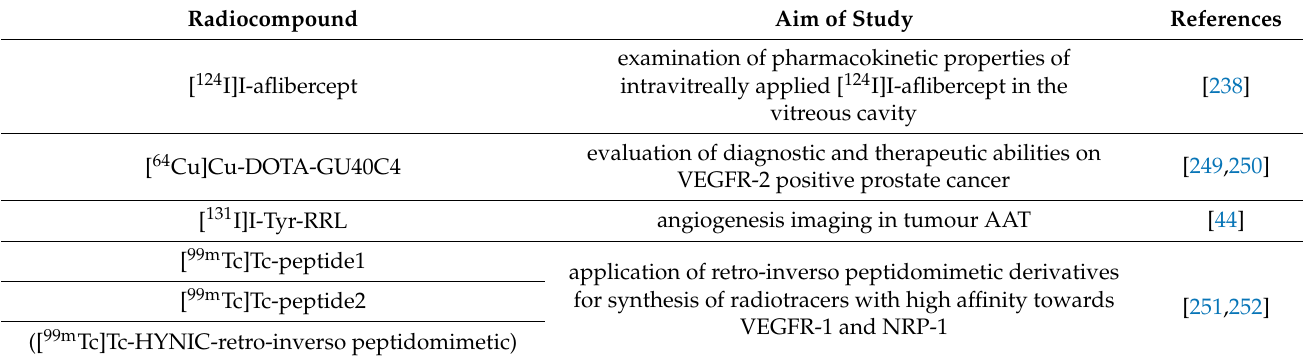
Table 3. Radiolabelled peptide-like structure ligands used as radiotracers for VEGF/VEGFR system imaging.